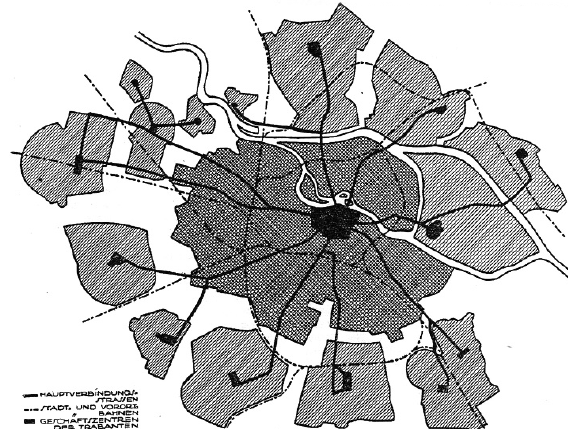
Figure 5. Proposed Satellite Plan for Breslau. Source: May